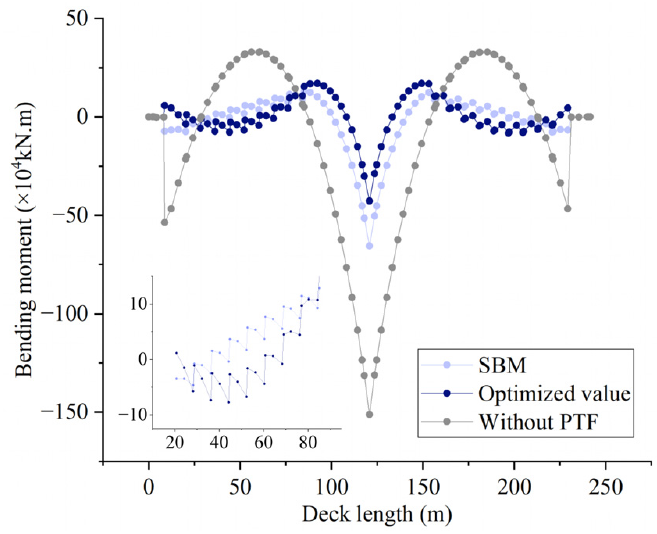
Figure 17. Main beam bending moment before and after optimization.